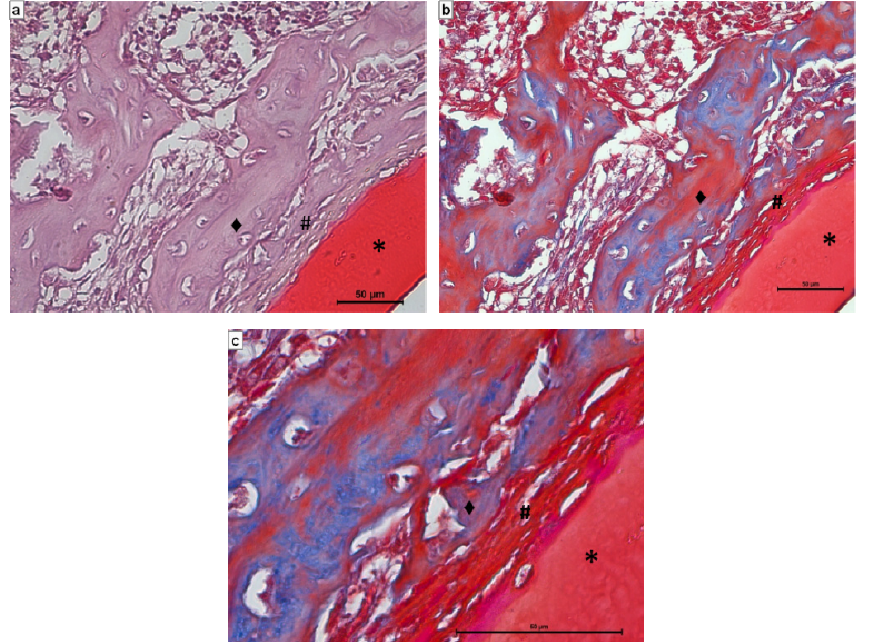
Figure 10. Histological evaluation of CS/Sol-Si biocomposite at 14 days post-implantation. At the tissue–biomaterial interface, there is reparative granulation tissue (#), which is progressively replaced by woven bone tissue ( ♦ ). Figures a and b correspond to the same image, ( a ) stained with H-E and ( b ) stained with Masson’s trichrome. ( c ) Higher magnification of part of image ( b ). Blue clearly shows the osteoid tissue that progressively replaces the reparative granulation tissue (red) next to the biomaterial (*). ( a , b ) Orig. Mag. × 400. ( c ) Orig. Mag. ×1000. ( a ) H-E stain. ( b , c ) Masson’s trichrome.